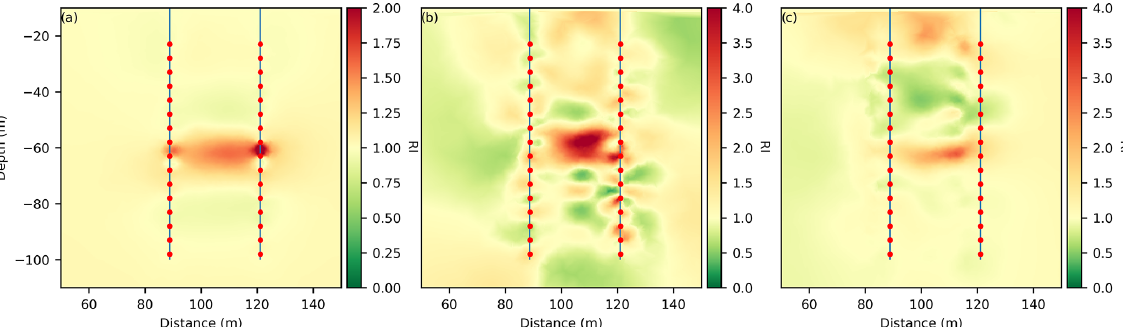
Figure 5. Inversion results for selection criteria. 1000 Configurations have been selected for each configuration ensemble. (a) Geometry optimized schedule. (b) Sensitivity optimized schedule. (c) Overview/random schedule. Note the adjusted color scale for (a) . The Chi 2 misfits for the inverion result containning the CO 2 plume are (a) 0.11, (b) 0.54, (c) 0.32.